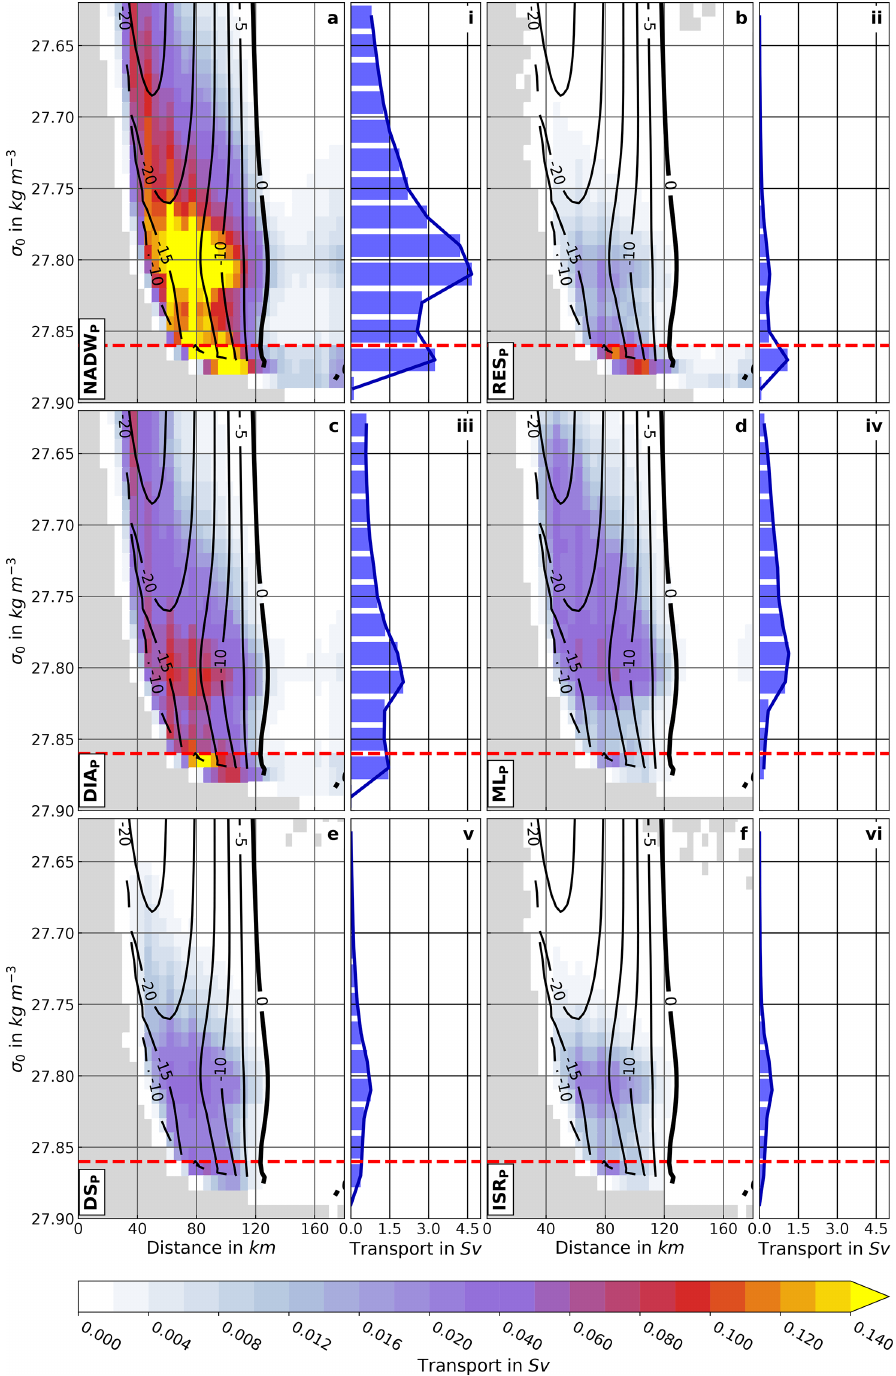
Figure 2. Mean transport distribution at 53 ◦ N (in Sv) in density space ( a to f , shading, 5km × 0.01kgm − 3 distance–density bins) and mean transport accumulated along 53 ◦ N (in Sv) (i) to (vi) , 0.02kgm − 3 bins). The dashed red lines mark the mean σ 0 = 27 . 86kgm − 3 isopycnal. Black contours in (a) to (f) are mean meridional velocities (in cms − 1 ). Note the nonlinear color scale (0.002Sv intervals up to 0.02 and 0.01Sv intervals starting from 0.02Sv) for (a) to (f) . Mean transport distributions are shown for (a, i) NADW P , (b, ii) RES P , (c, iii) DIA P , (d, iv) ML P , (e, v) DS P , and (f, vi) ISR P (see Sect. 2.1.3 for details of the definitions).